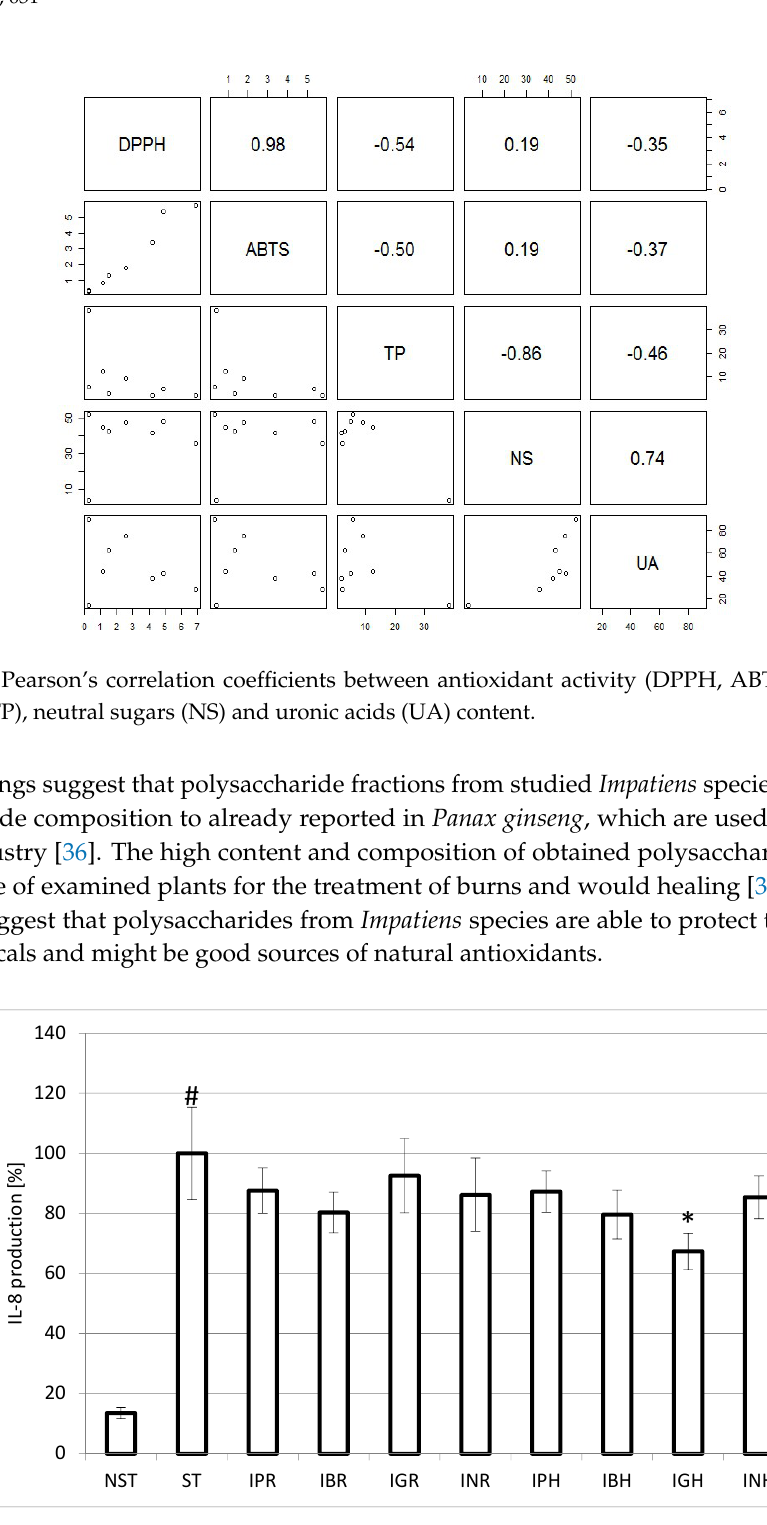
Figure 4. Effect of polysaccharides of Impatiens L. at the concentration of 50 μg/mL on interleukin-8 (IL-8) production by lipopolysacharide (LPS) stimulated neutrophils. Data were expressed as mean ± SEM of three separate experiments performed with neutrophils isolated from independent donors assayed in duplicate. * p < 0.05 versus stimulated control. #- statistically significant ( p < 0.001) versus non-stimulated control; ST- stimulated control; NST- non-stimulated control.